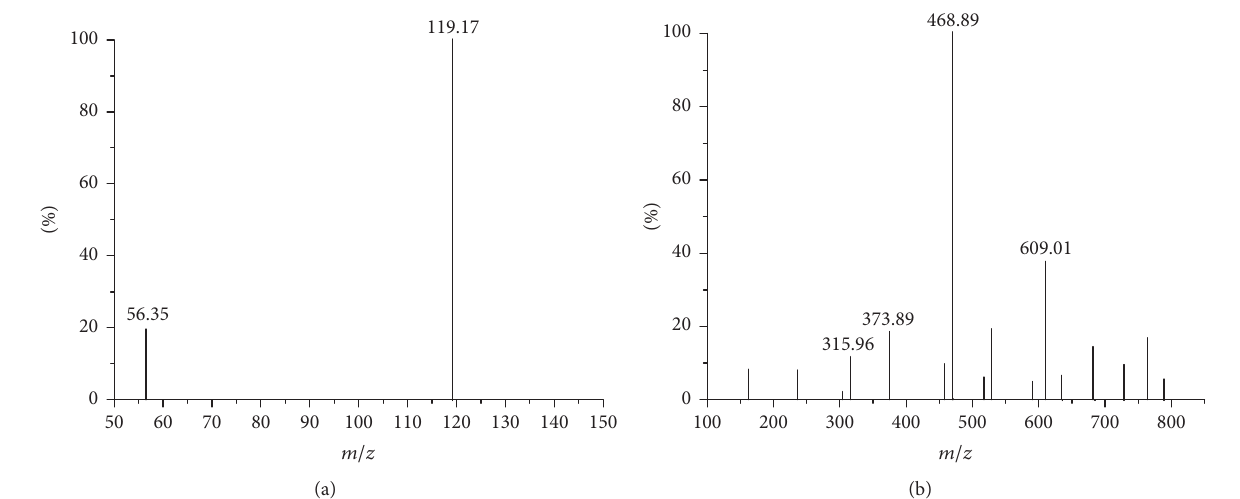
Figure 4: Full-scan positive electrospray mass spectrum of DABA (a) and DABA-Co(II) (b).